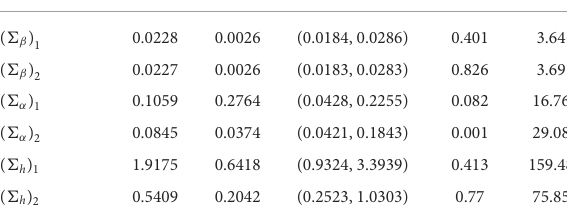
TABLE 2 Estimation results of the selected parameters in the TVP-SVAR-SV mode. Parameters Mean St. dev. 95% interval Geweke